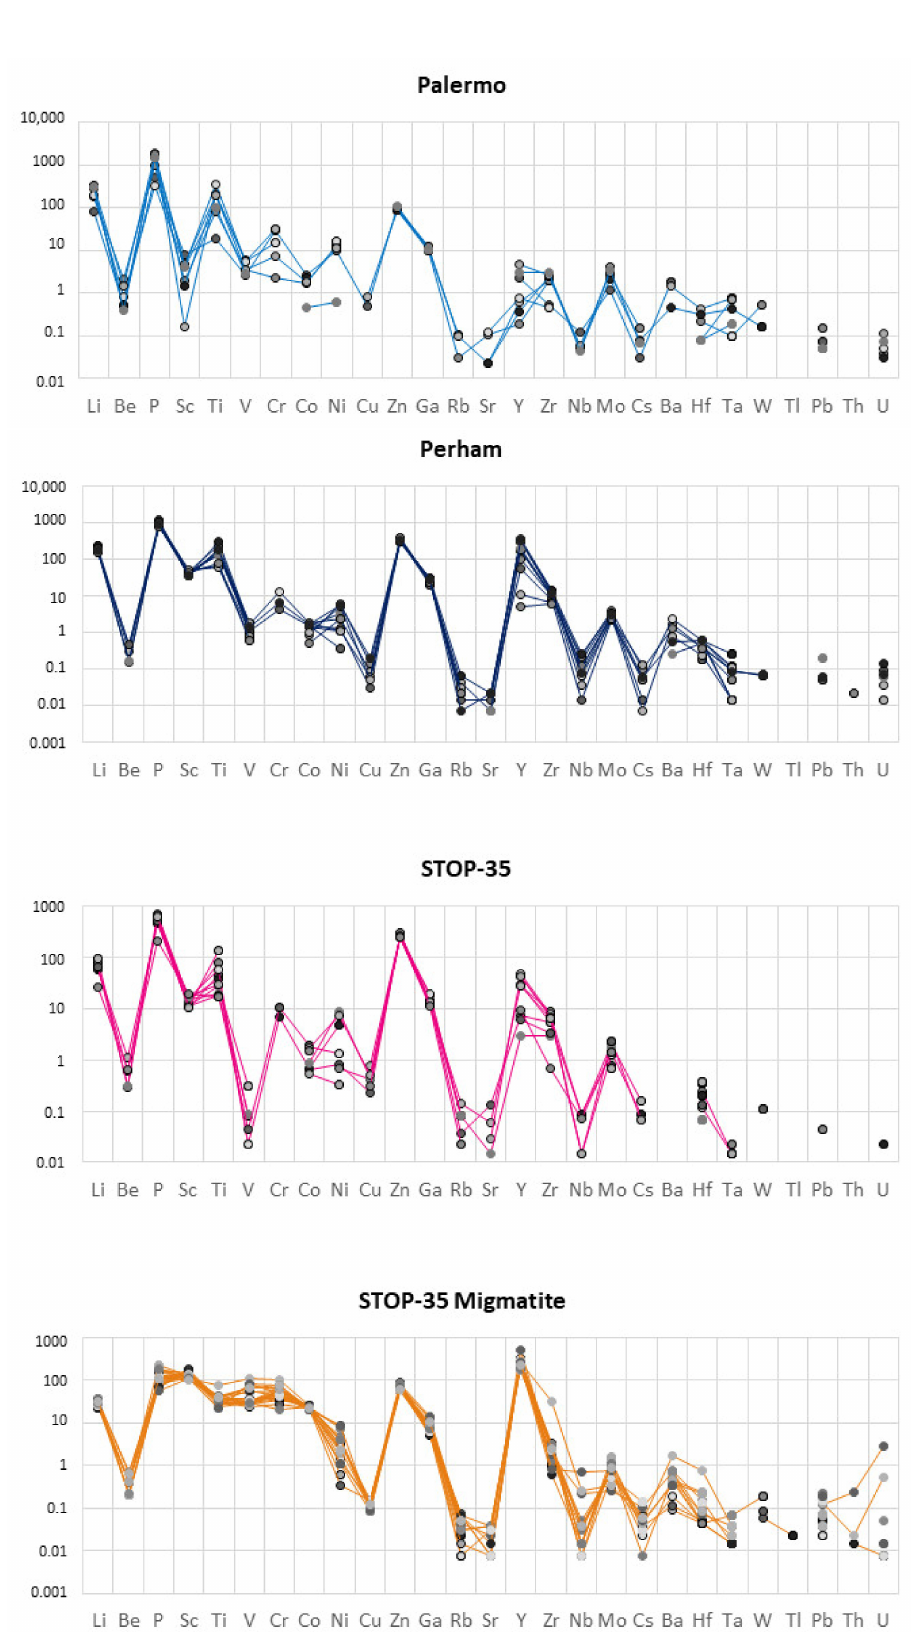
Figure 12. Trace elements spider diagrams for the garnets from the studied